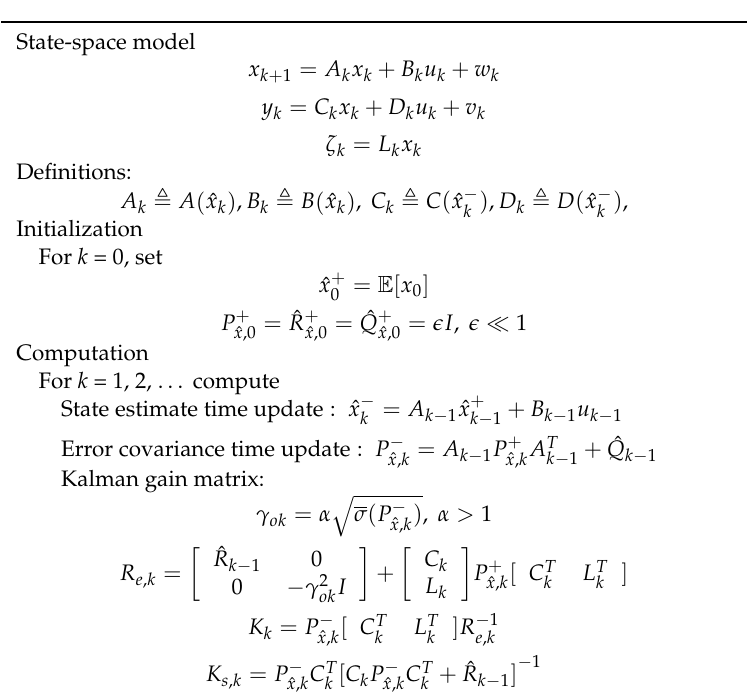
Table 9. Summary of the adaptive H ∞ filter for SOC estimation